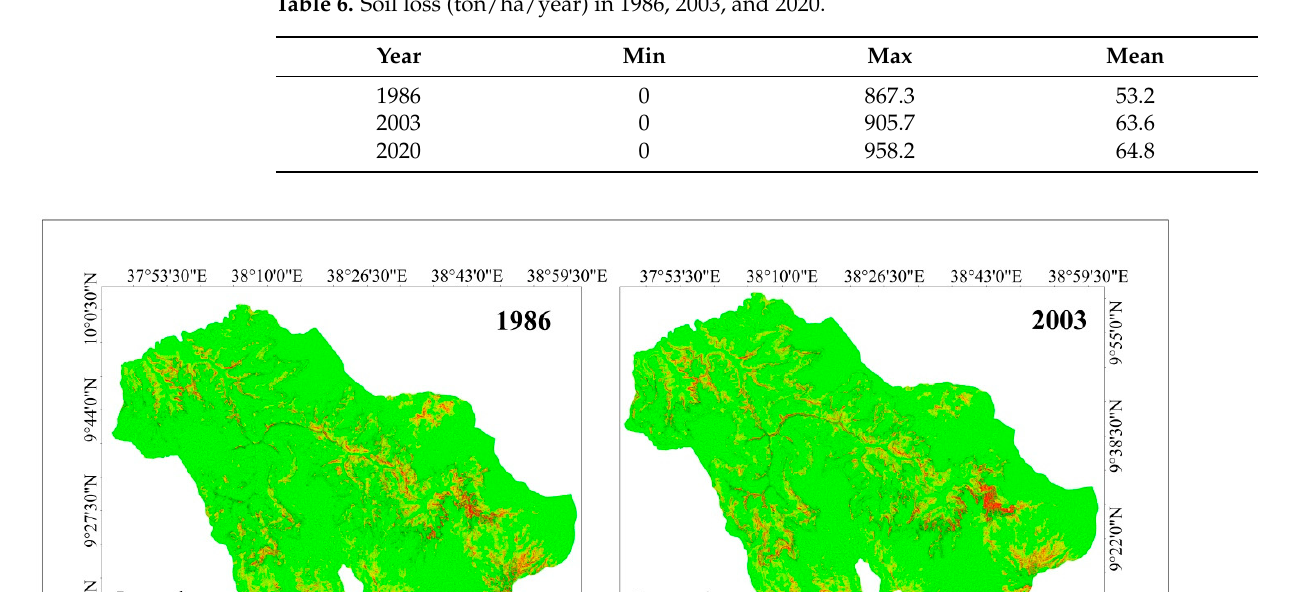
Table 6. Soil loss (ton/ha/year) in 1986, 2003, and 2020.